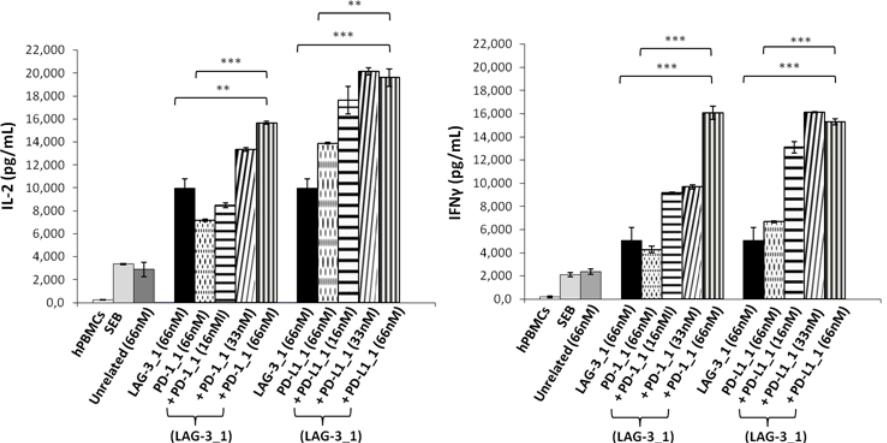
Figure 1. Effects of the combinatorial treatments on secretion of cytokines by stimulated T cells. hPBMCs were incubated with SEB (50 ng/mL) in the absence or presence of LAG-3_1, PD-1_1 or PD-L1_1 antibodies, used alone or in combinations for 66 h at 37 ◦ C. Cytokine secretion was measured in the supernatants by evaluating the levels of IL-2 and IFN γ by ELISA. An unrelated antibody was used in parallel assays as a negative control. Error bars depict means ± SD. p -value: *** p ≤ 0.001; ** p < 0.01.